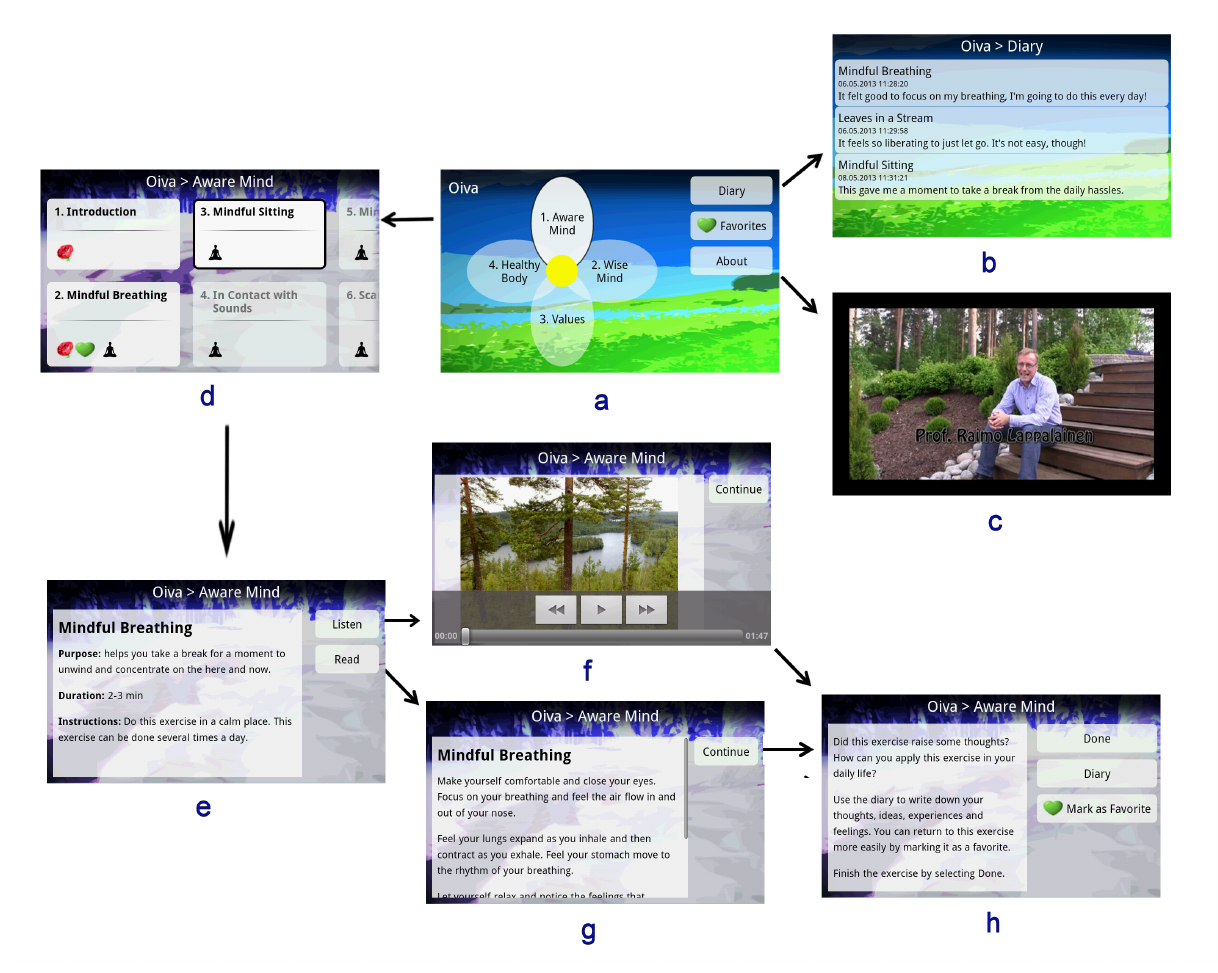
Figure 1. Screenshots of Oiva. (a) the main screen, (b) diary, (c) introduction video, (d) top menu of Aware Mind, (e) exercise introduction screen, (f) audio exercise, (g) text exercise, (h) exercise reflection